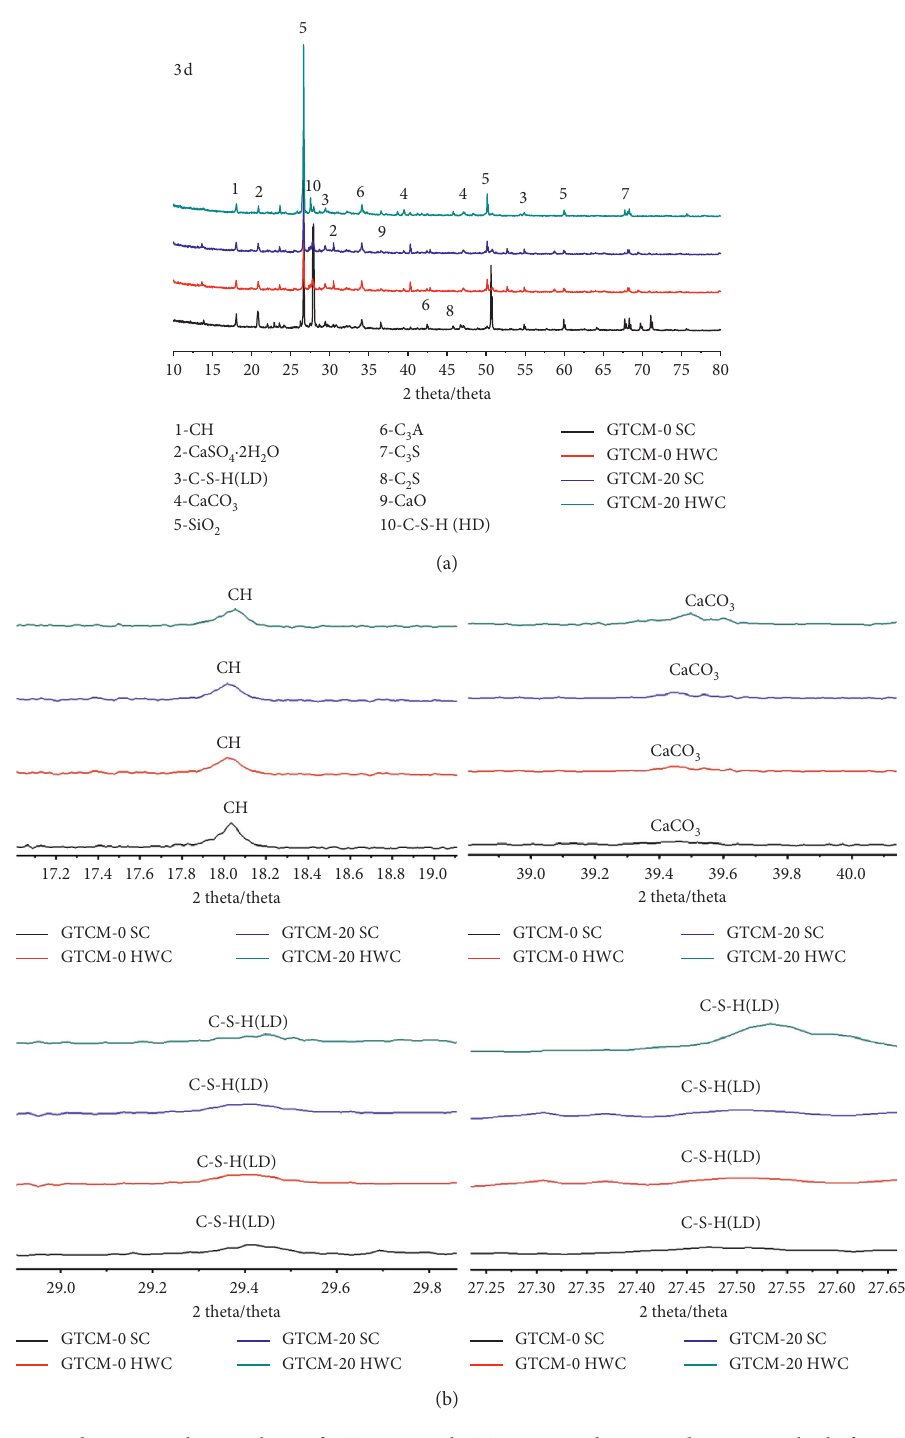
Figure 9: Hydration product analysis of GTCM-0 and GTCM-20 under SC and HWC methods for 3